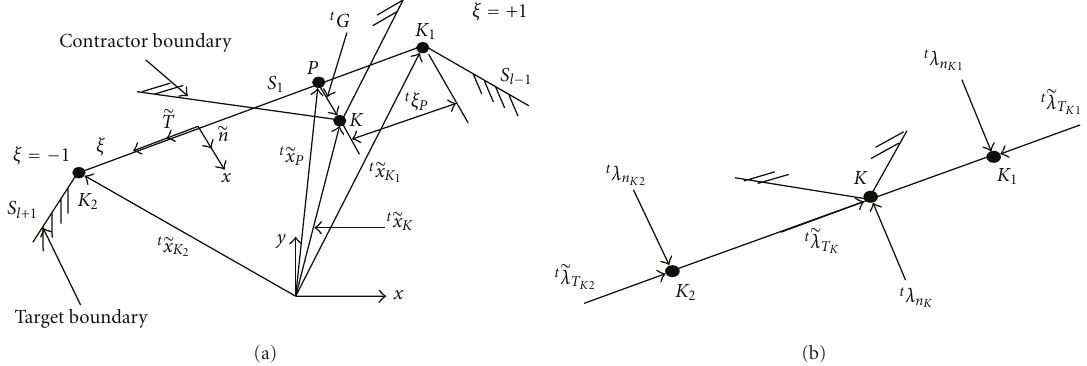
Figure 3: Modeling of the contact interface, (a) a contactor node K in contact with a target segment S l and (b) contact forces at the contact